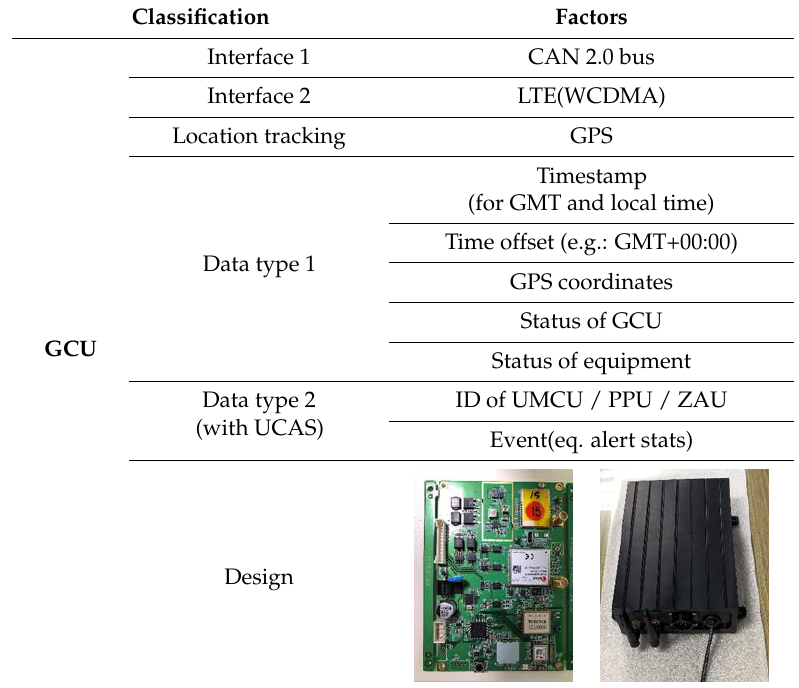
Table 4. Specifications and data types of GCU.